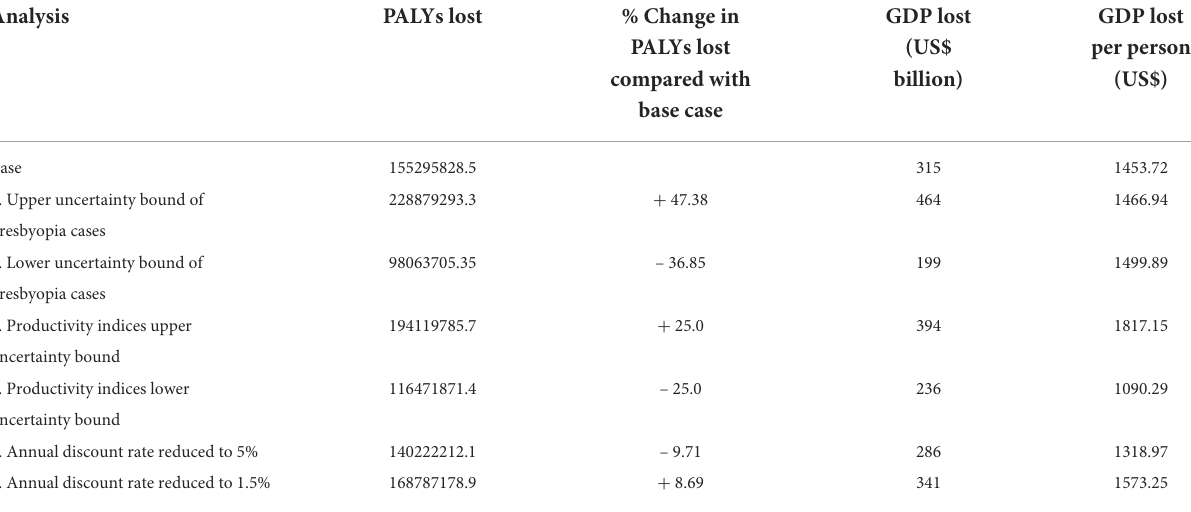
TABLE 4 Sensitivity and scenario analyses to assess the impact of the uncertainties around productivity, and economic data inputs on PALYs lost in those with presbyopia in the population and the associated economic impact.